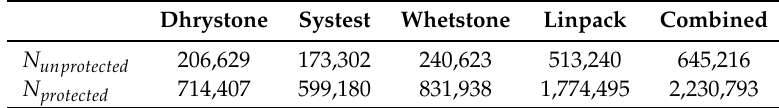
Table 7. Number of critical bits for both unprotected and DTMR-protected versions of the Rocket RISC-V processor.